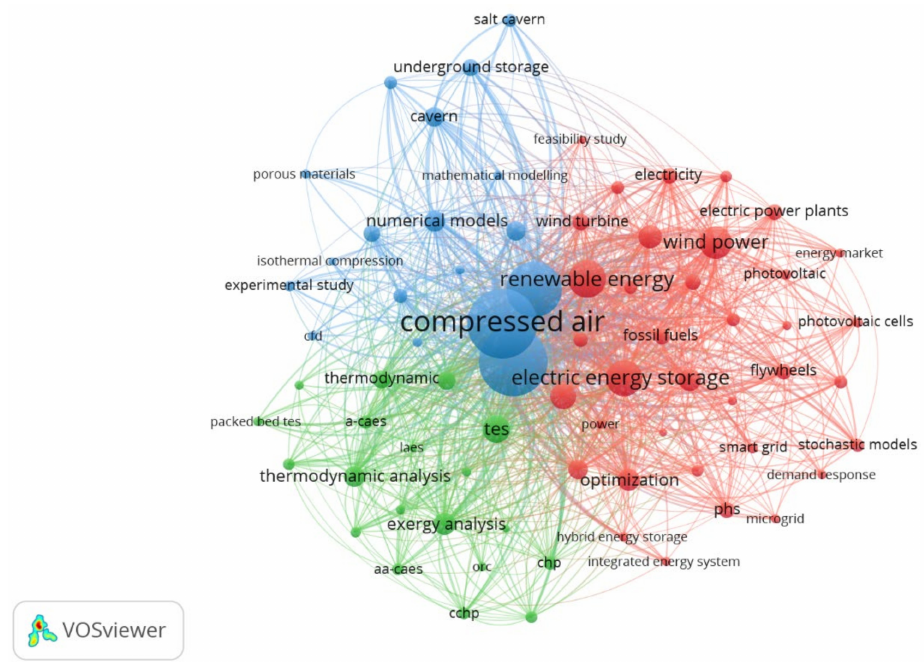
Figure 9. Co-occurency of keywords related to publications on